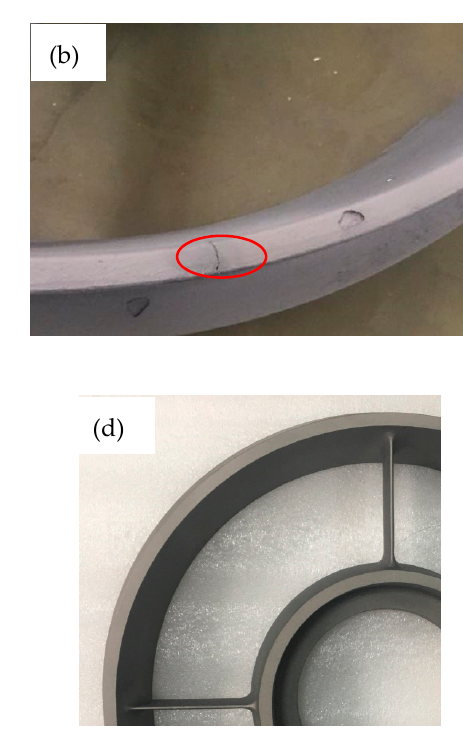
Figure 5. Misrun risk prediction results of 4× ( a ) and 8× ( b ) gravity gating systems. In ( a ) misrun risk was seen in the 4× cross runner while misrun risk was not seen in the 8× cross runner.